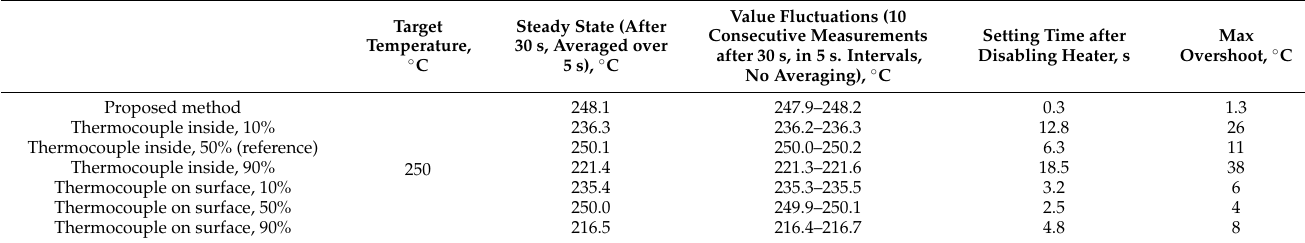
Table 6. Temperature measurement (experimental) results.